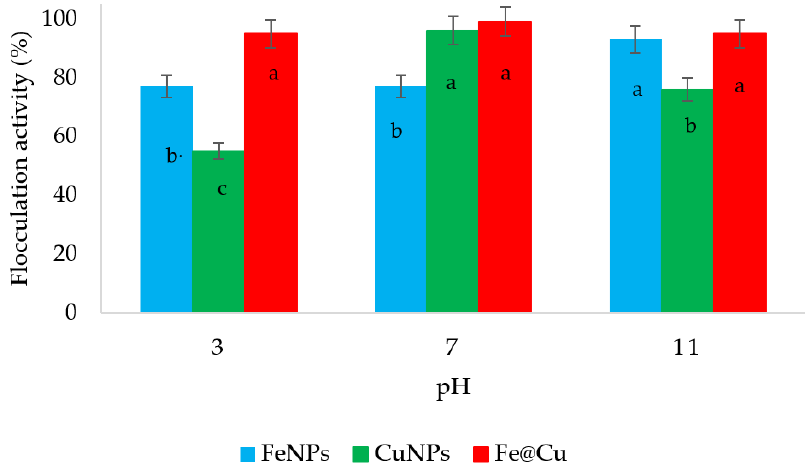
Figure 2. E ff ect of pH on flocculation activity of nanoparticles at room temperature di ff erent letters Figure 2. Effect of pH on flocculation activity of nanoparticles at room temperature different letters (a, b and c) denotes statistical significance at ( p < 0.05). (a, b and c) denotes statistical significance at ( p < 0.05).